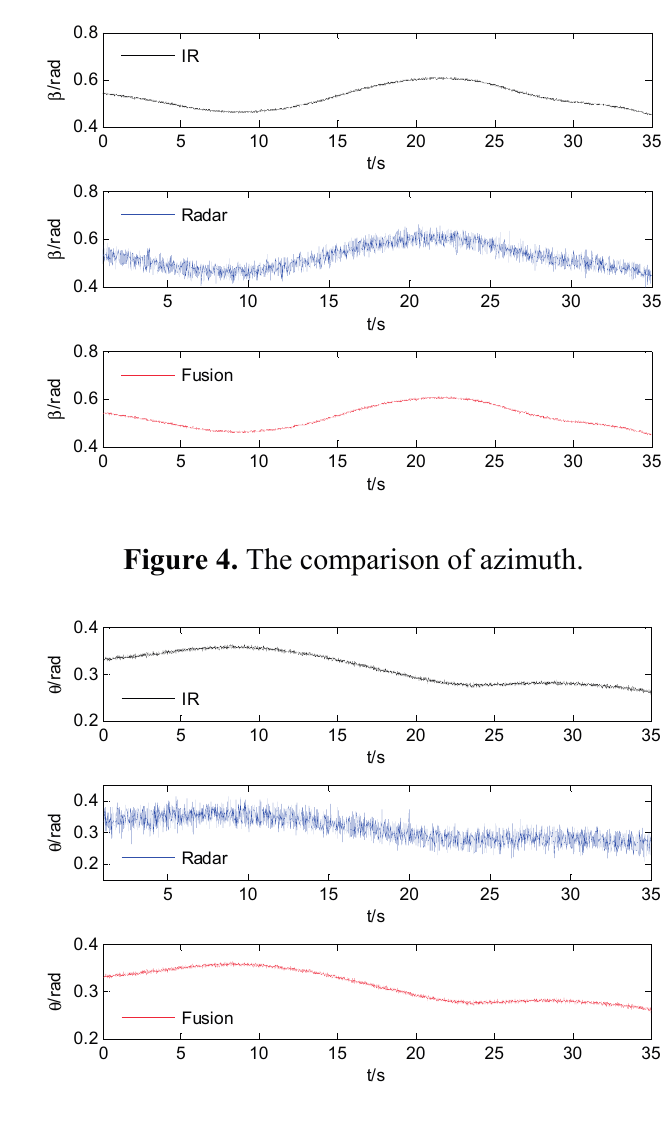
Figure 5. The comparison of